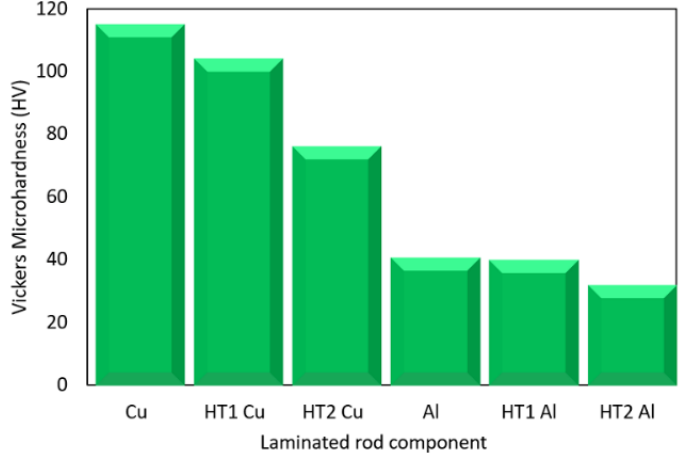
Figure 9. Measured Vickers microhardness values for laminates’ components.